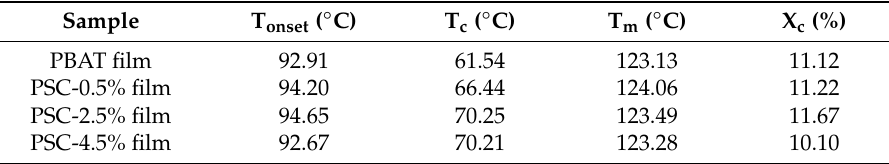
Table 3. DSC parameters of PBAT and PSC films.